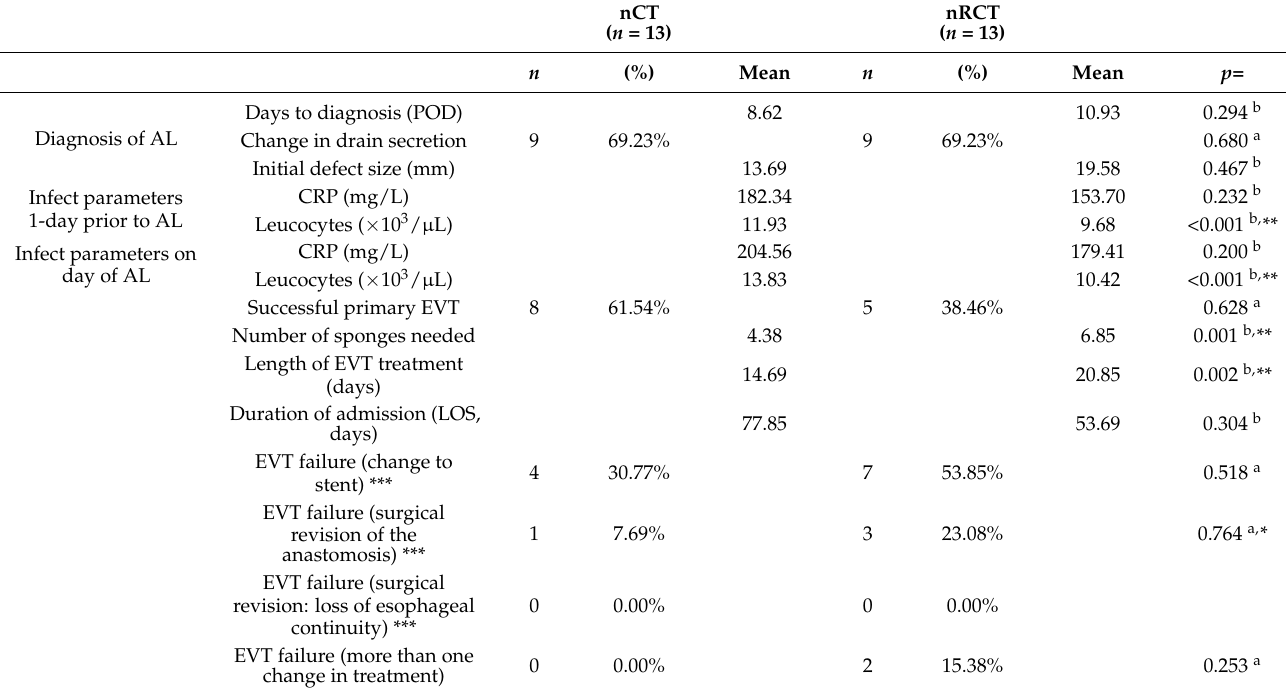
Table 3. EVT therapy and perioperative complications after esophageal